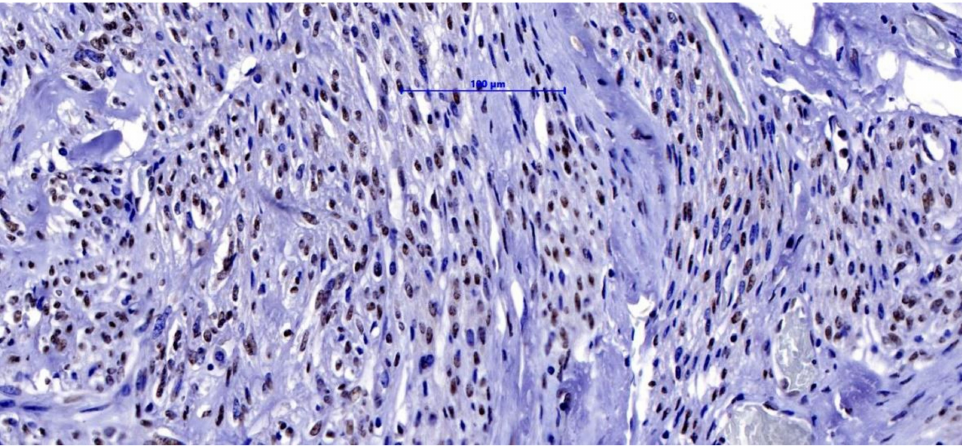
Figure 3. The nuclei of the myometrium stained with Vit. D3 Receptor antibody, 300 × . Slides were incubated in a water bath at 96 ◦ C in citrate buffer at pH 6.0 for 50 min. Endogenous peroxidase activity was blocked with 3% H 2 O 2